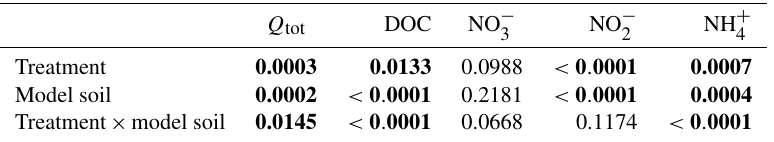
Table 3. Results of the two-way analysis of variance (ANOVA) of the integrated fluxes ( Q tot ) and the mean concentrations of chemical properties in soil solution ( n = 6) during the period of enhanced N 2 O emissions (from day 11 to day 25). Shown are P values with significant differences ( P < 0 . 05) highlighted in bold characters.